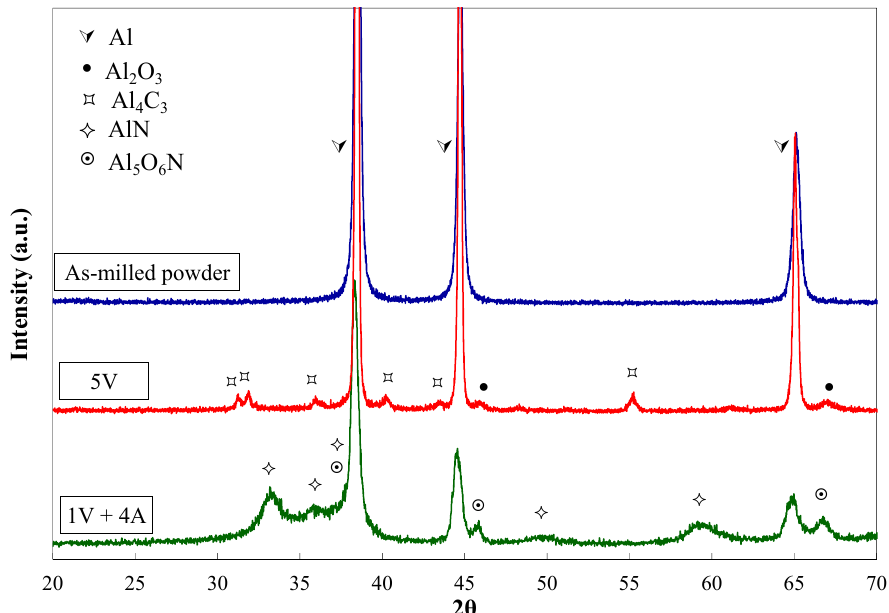
Figure 2. XRD patterns of as-milled powders and 5V and 1V + 4A powders after being milled and heat treated.